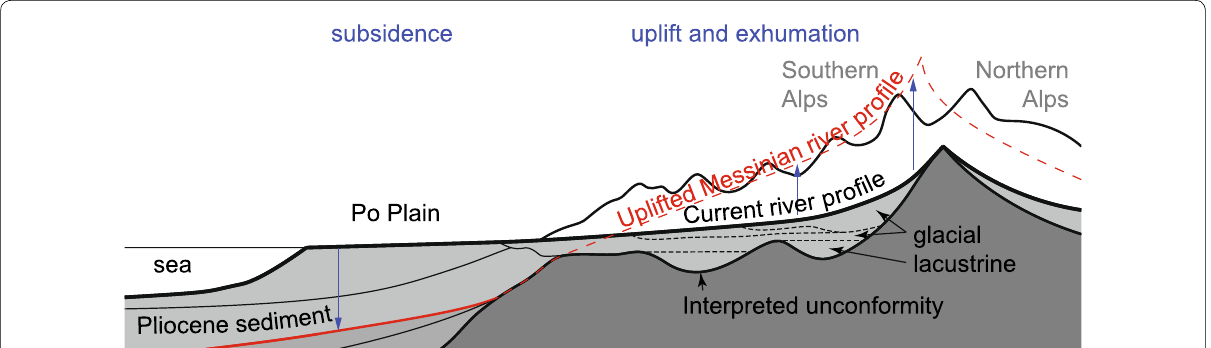
Fig. 10 Schematic section along the Adige River for the present day. The surface is shown in thick black lines, crystalline rock in dark grey and sediments in light grey shading. The Messinian river profile is uplifted and eroded or subsided according to the rock uplift and subsidence rates displayed as blue arrows. Messinian surfaces (red) were eroded away within the Alps, they are only preserved in the Po Plain and the transition into the